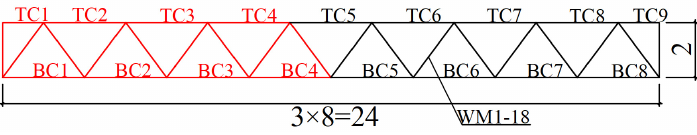
Figure 1. The geometry of truss-PJ (unit: mm).